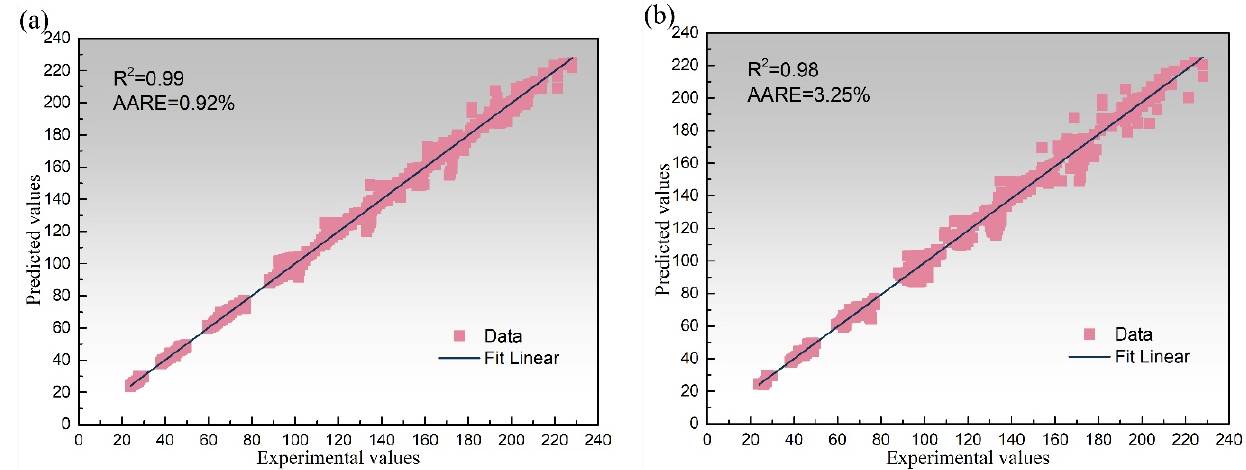
Figure 14. Comparison of experimental and cross-validation ANN predicted flow stresses of ( a ) training subsets and ( b ) testing subsets.